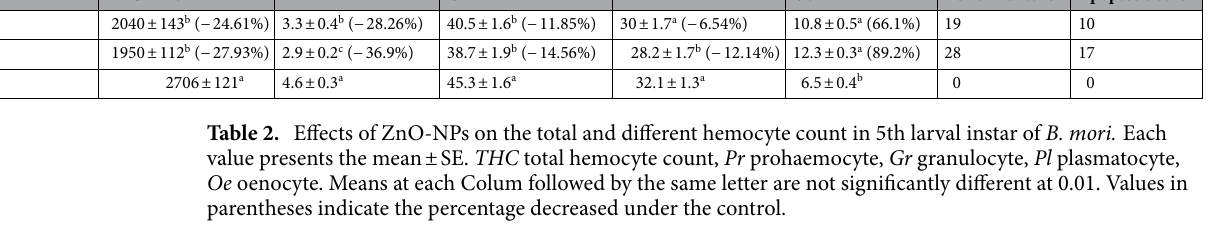
Concentration (μg/ ml) THC mm3 Pr Gr Pl Oe Abnormal cells Apoptotic